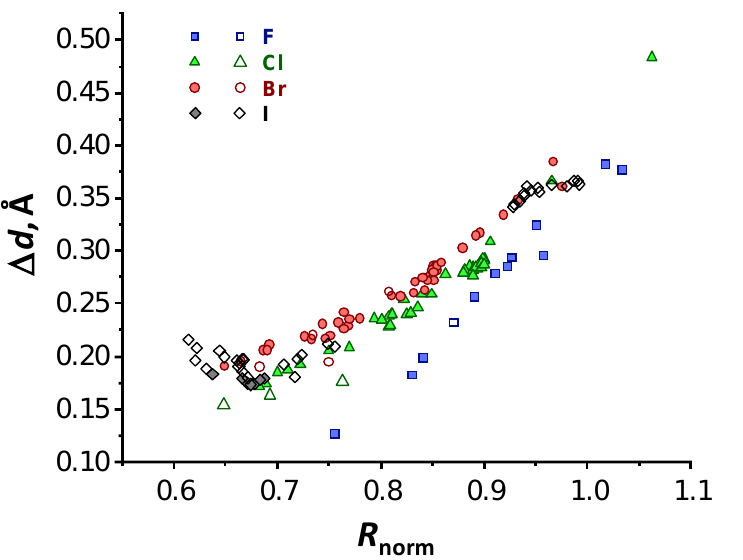
Figure 6. Distances between ED and ESP minima ∆ d as a function of normalized interatomic distances R norm between X (X = F, Cl, Br and I) and O (see definition in Equation (5)).